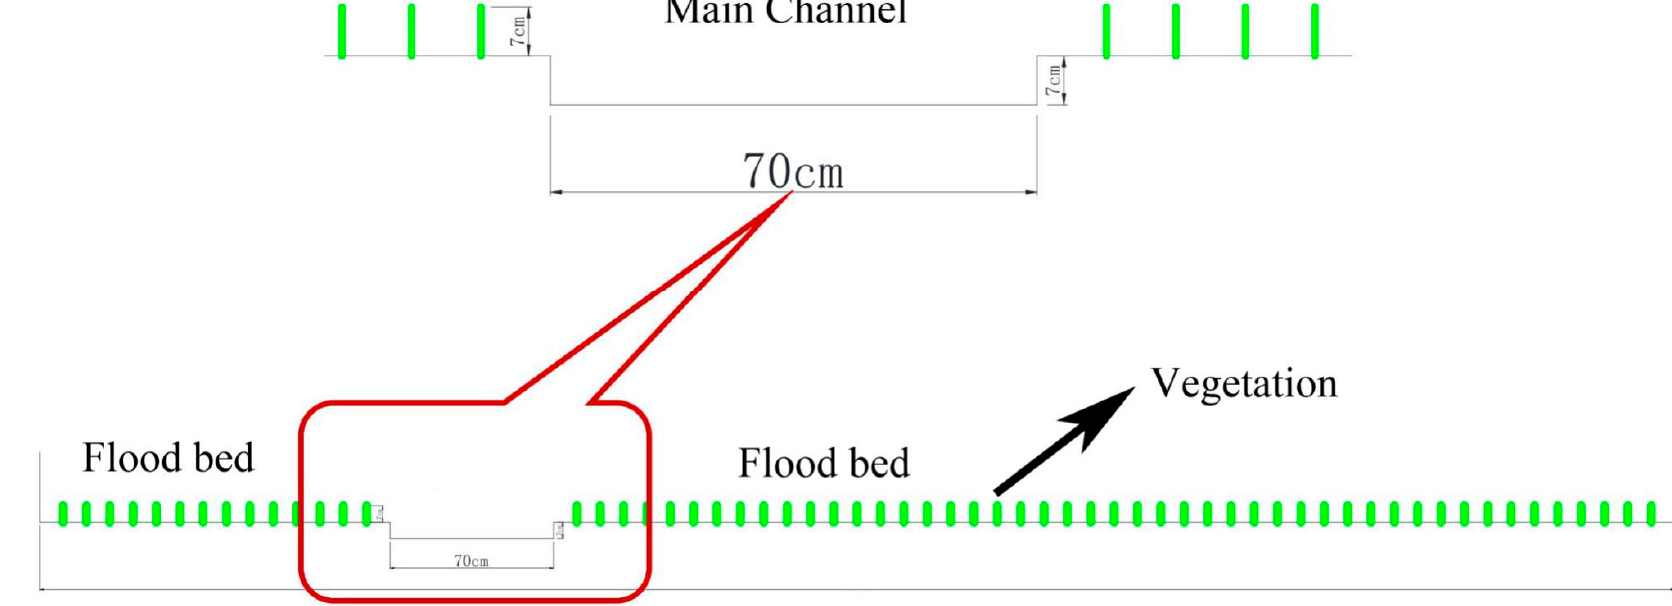
Figure 2. Cross section of the arc top section of the meandering compound channel.